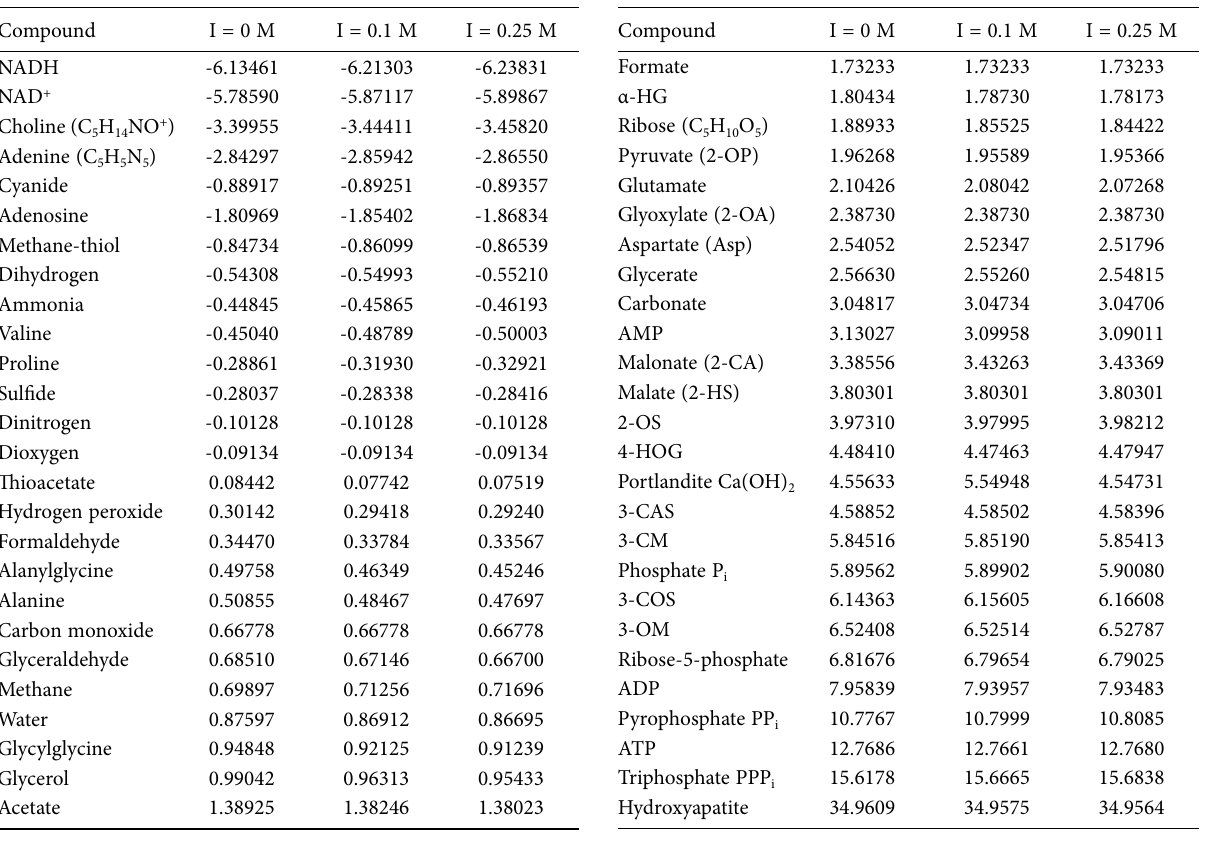
Table 4. Aqueous irreversibility potentials Π’ i ° (zJ·K -1 ) at a pressure of 100 kPa, pH = 7 and three different ionic strengths I. This table is based on the convention that Π i ° = 0 for species H + , adenosine, NAD - and NADP 3 - at zero ionic